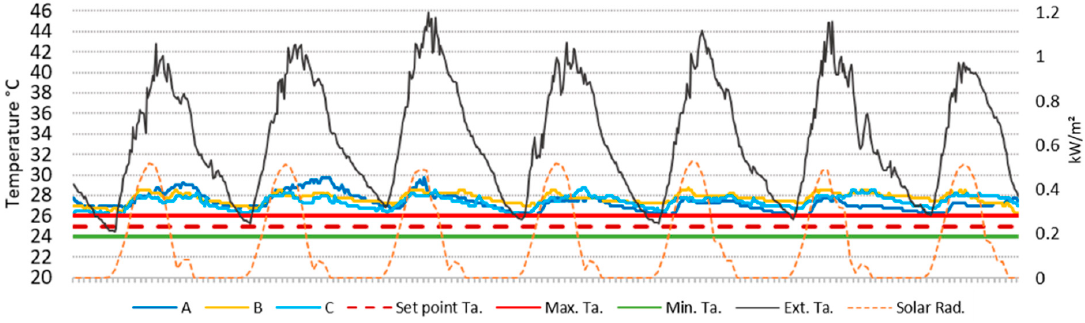
Figure 8. Monitored data collected for rooms during the selected week, August 1 st to 7 th .